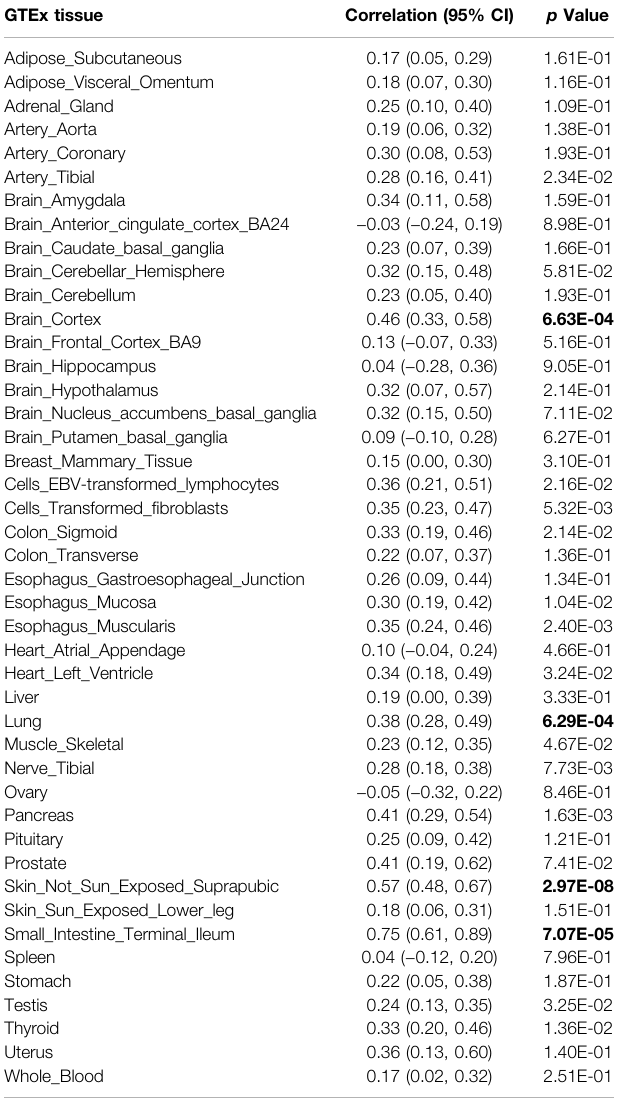
TABLE 2 | Disease-inferred gene expression pro fi le overlap between ALS and schizophrenia in GTEx v7 reference panel tissues. GTEx